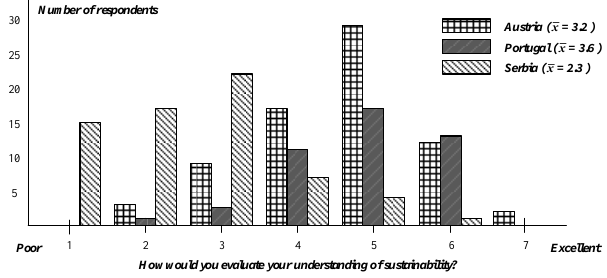
Figure 2: Respondents’ self-assessment